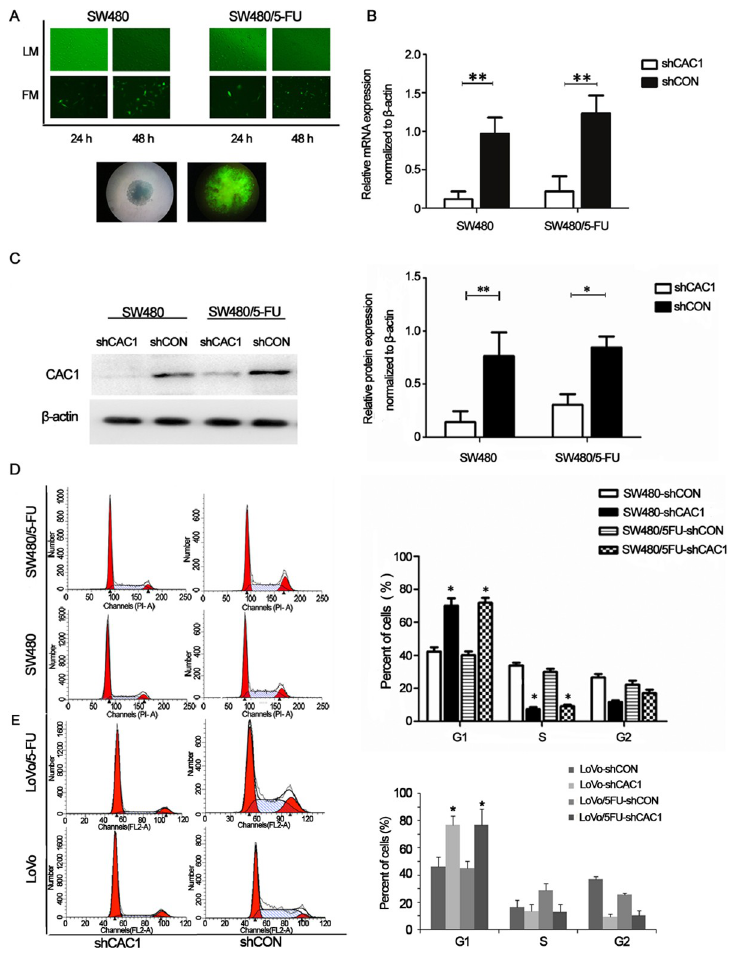
Fig 3. CAC1 knockdown induced the arrest of SW480/5-FU cells in the G1/S phase. (A) The stable shCAC1 transfection of SW480 and SW480/5-FU cells for 24–48 hours. (B) The quantitative RT-PCR analysis of CAC1 mRNA expression in SW480 and SW480/5-FU cells following CAC1 knockdown. (C) The western blot analysis of CAC1 protein expression in SW480 and SW480/5-FU cells following CAC1 knockdown. CAC1 knockdown induced cell cycle arrest at the G1 phase in SW480, SW480/5-FU cells (D) and LoVo, LoVo/5-FU cells (E). Cells were stably transfected with shCAC1 for one week, and the cell cycle profile was detected using FACS analysis following propidium iodide staining. The representative results of three independent experiments are shown. � P < 0.05, �� P < 0.01.